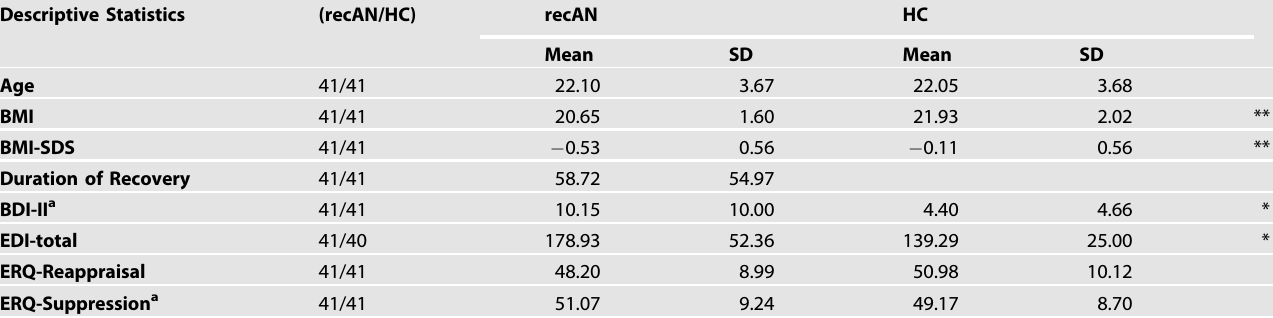
Table 1. Descriptive statistics, results of group comparisons using independent samples T -tests, displaying mean and standard deviation. Descriptive